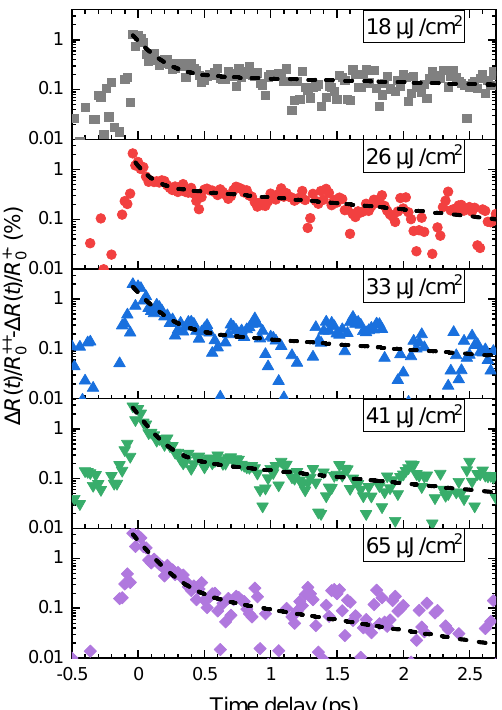
Figure 3. Valley polarization dynamics of 1sA excitons in WSe 2 monolayer. The data are obtained by subtracting the transient reflectivity dynamics of the exciton line for counter-rotating polarizations of pump and probe pulses (red curve shown in Figure 2b) from the dynamics measured with co-rotating polarizations (black curve in Figure 2b). The data are spectrally integrated in the photon energy region 1.61–1.67 eV. The dashed curves correspond to double-exponential fitting